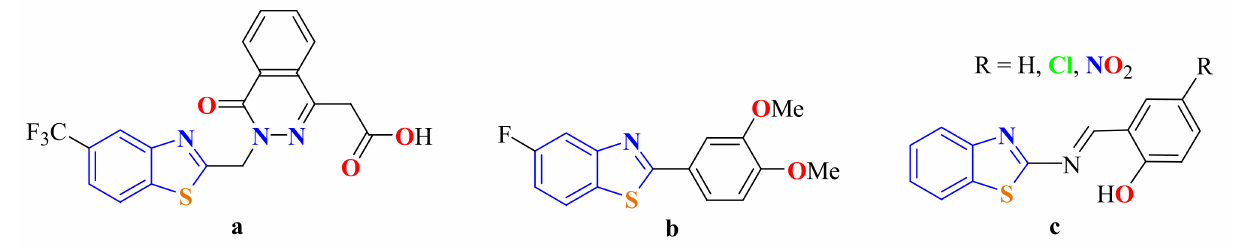
Figure 3. Benzothiazole as core nucleous in synthesized